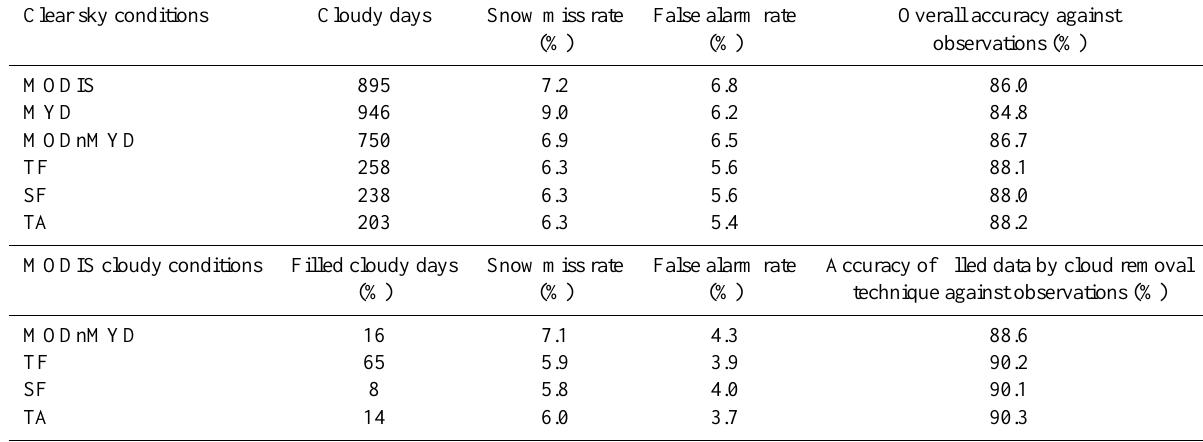
Table 4. Results of the absolute validation of the cloud removal technique; MODnMYD refers to MOD10A1 and MYD10A1 combined images, TF refers to temporally filled images, SF refers to spatially filled images, and TA refers to temporally analysed images. Clear sky conditions